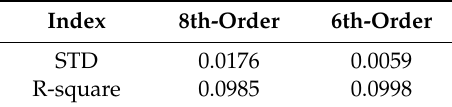
Figure 2. SOC–OCV relationship curve: ( a ) 8th-order polynomial function fitting curve; ( b ) 6th-order polynomial plus a logarithmic term function fitting curve. Table 2. Comparative analysis of fitting results.